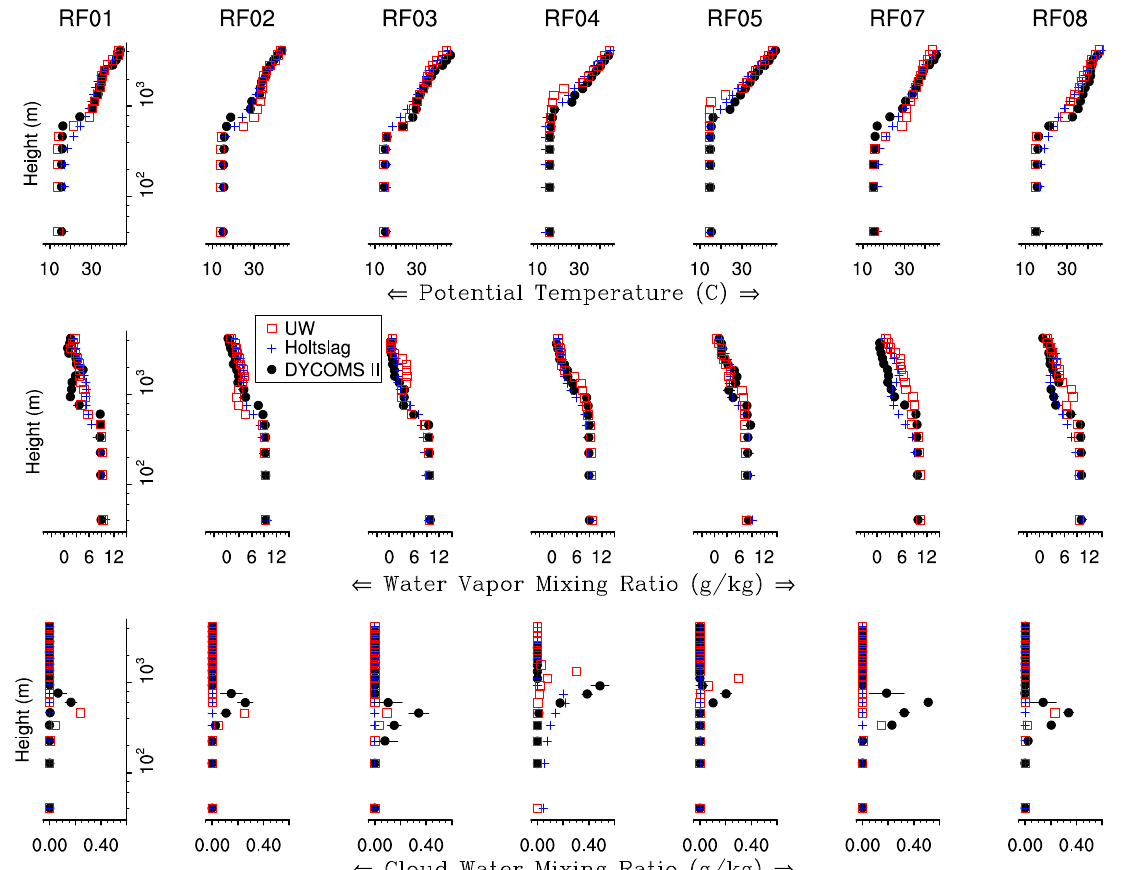
Fig. 7. Profiles of potential temperature (top row), specific humidity (middle row), and liquid water mixing ratio (bottom row) from 7 of the 10 research flights of the second Dynamics and Chemistry of Stratocumulus Experiment (DYCOMS II; plotted in black), plotted with comparable data from RegCM with the UW model (red) and Holtslag model (blue). Each column represents a research flight (RF). The height scale is logarithmic and is the same for each plot, and the horizontal scales are identical among like